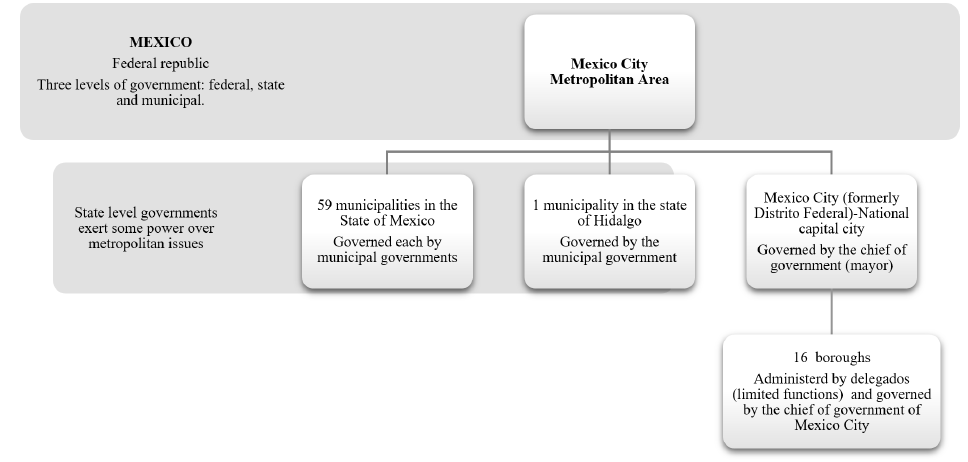
Figure 4: Government structure, Mexico City Metropolitan